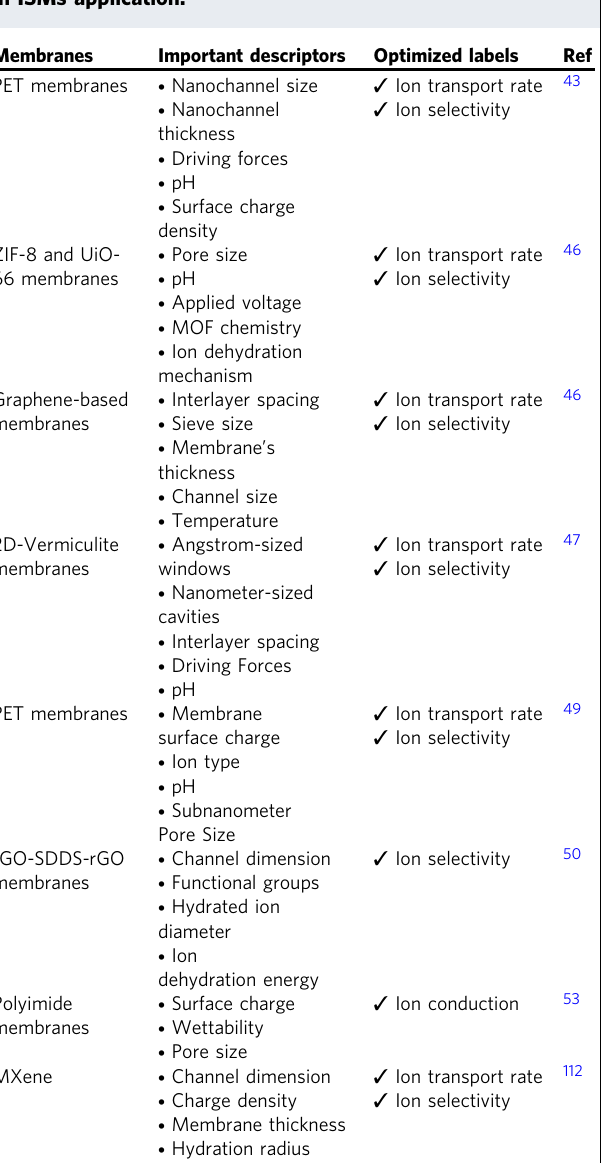
Table 1 Different descriptors and labels for the AI methods in ISMs